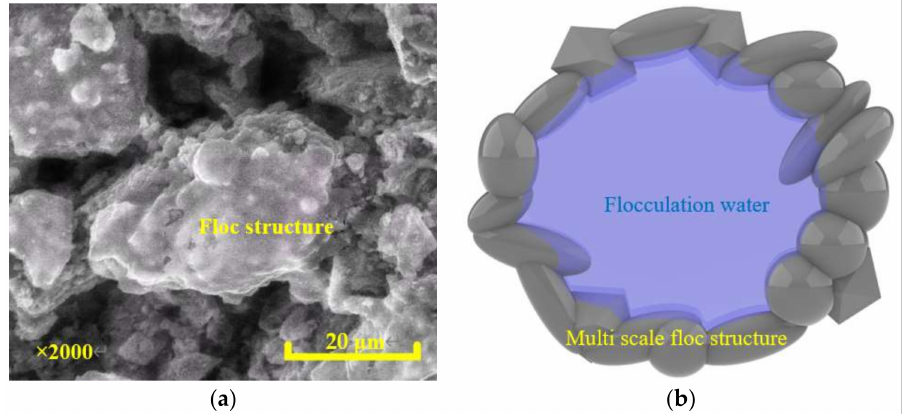
Figure 8. The floc structure: ( a ) SEM image; ( b ) schematic diagram. The flocculation partially turned the free water into flocculated water, leading to a decrease in the mass fraction of free water, and the latter had an evident influence on the paste’s fluidity and rheology. The friction resistance between particles increased with the reduced lubrication of the water, thus increasing the yield stress and plastic viscosity of the paste. Free water could provide hydrodynamic force to drive the particles in the paste to move forward, and less free water led to the weakening of the hydrodynamic force and also to poor fluidity. A number of particles that could not move forward in a steady state due to lack of force were likely to cause problems such as settlement, segregation and pipe